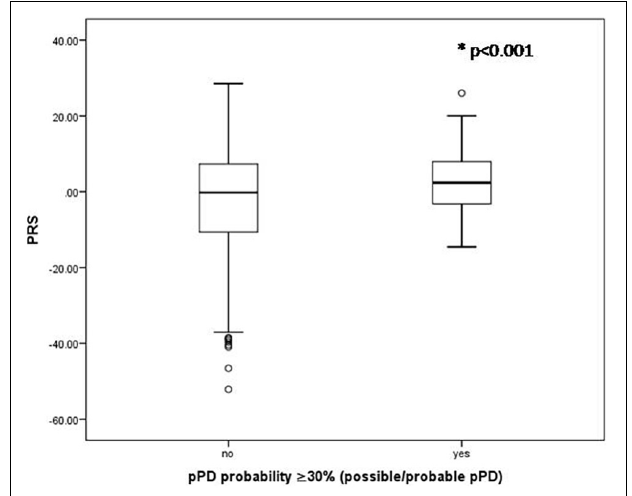
TABLE 1 | Sample characteristics ( n = 1,120).